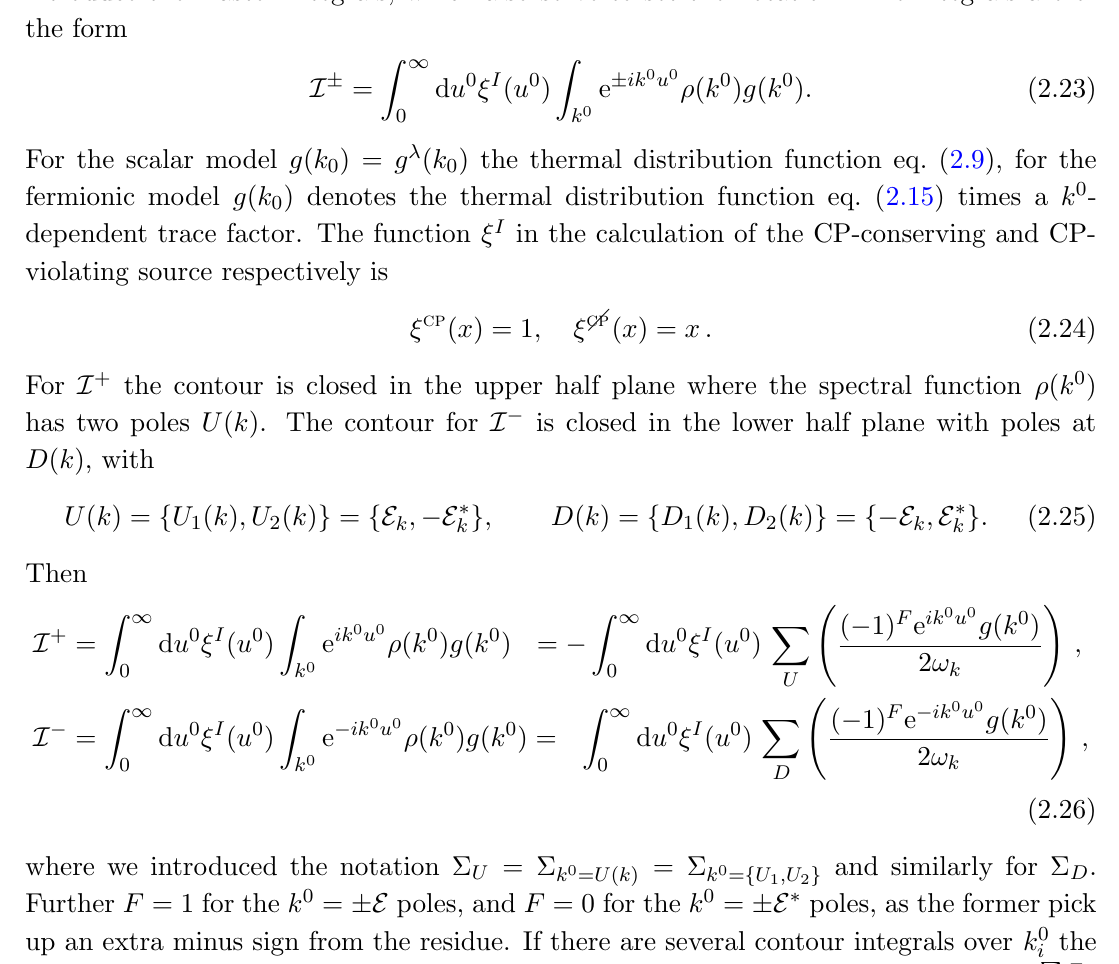
Figure 1 . Feynman diagrams for the LO and NLO contributions to the self-energy (cid:5) > legs with (cid:10) symbols denote vev insertions ’ b , and the plus/minus signs at the vertices indicate the coupling f (cid:6) . The diagrams for the fermionic self-energy (cid:6) > s replacement (cid:30) L;R ! L;R